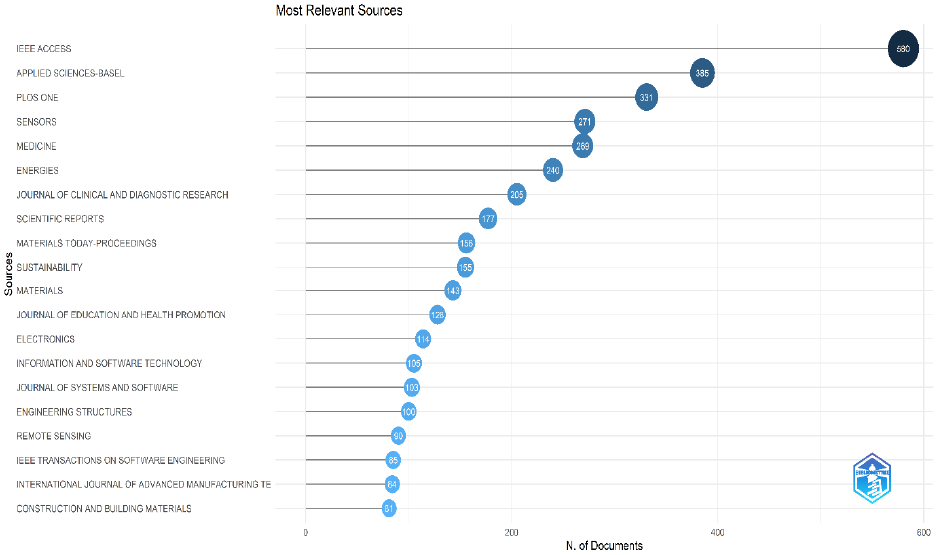
Figure 4. Top 20 most relevant sources of publications with respect to the publication count for the time frame 2019–2021.